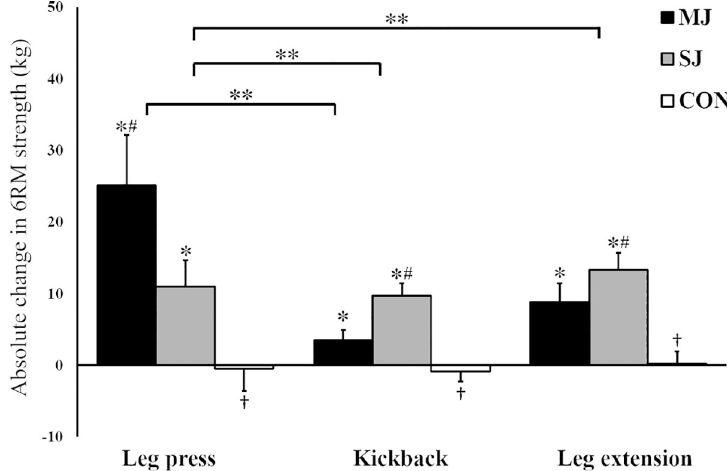
Fig 2. Absolute change (kg) in 6RM strength from pre- to post-test for the control (white bar), SJ (gray bar) and MJ groups (black bar). Error bars represent 95% confidence interval. � = Significant change from pre- to post-test ( P < 0.001). † = Significantly lower change than the training groups ( P < 0.01). # = Significant difference between training groups ( P < 0.01). �� = Significant difference between exercises ( P <